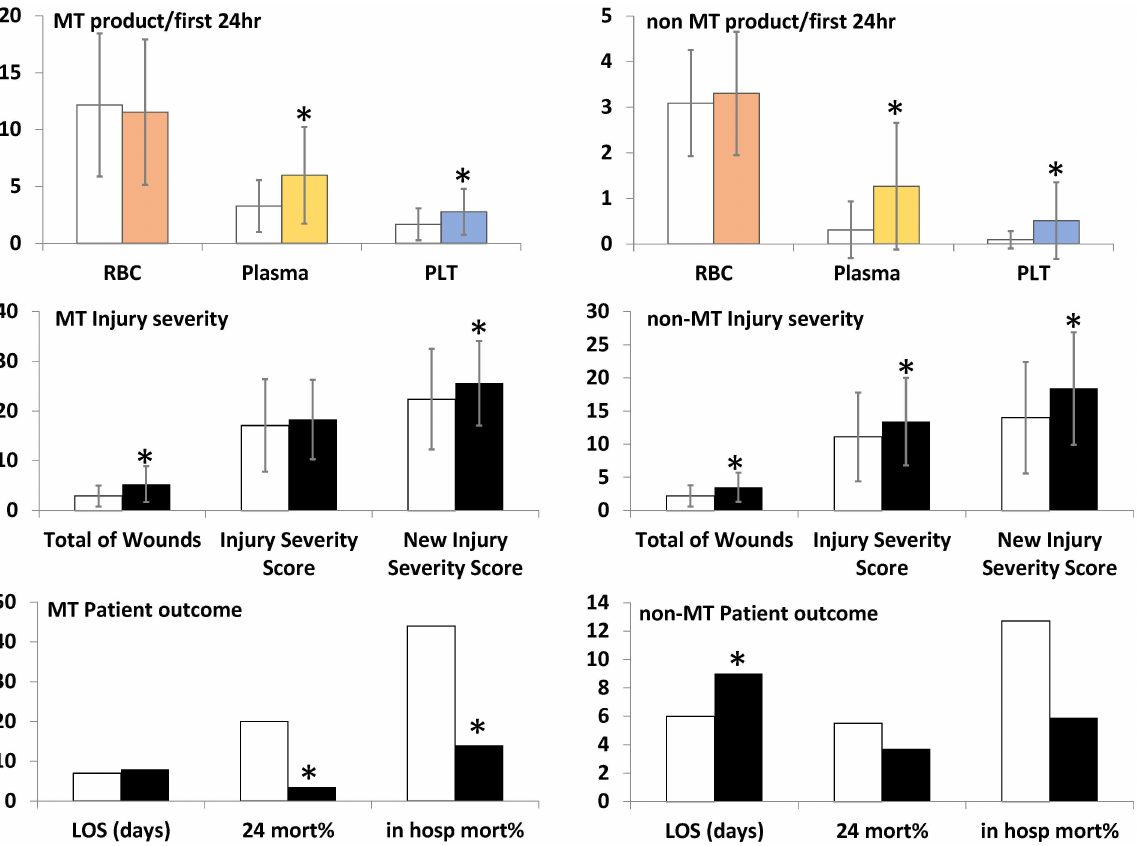
Fig 2. Transfusion, injury and outcome of MT and non-MT patients, pre- and post-MTP. MT indicatesmassive transfusion, MTP : Massive TransfusionProtocol, RBC : red blood cells; Plasma : frozen plasma; PLT : frozen platelets. clear bars : pre-MTP, paddedbars : post-MTP, * : significantly different comparedto